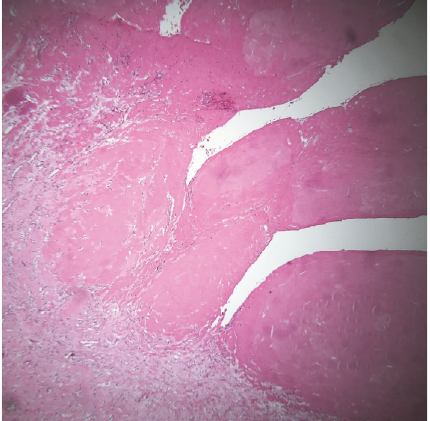
Figure 4: Anatomopathological view of the operative